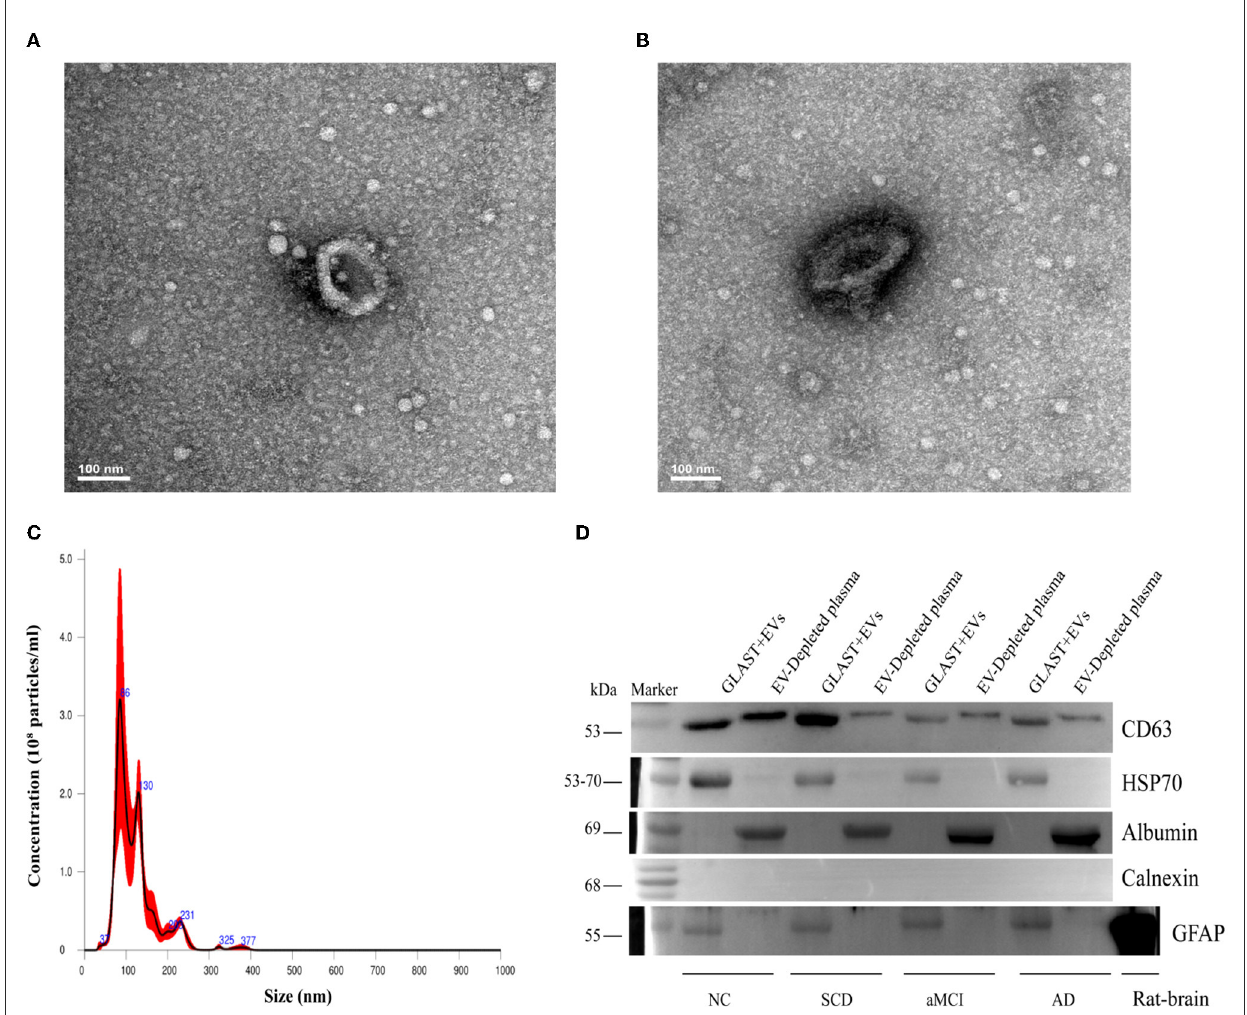
FIGURE1 Characterization of ADEs. (A, B) Typical TEM images of ADE. Characteristic image of ADE from one subject and the analysis was performed at Tsinghua University. (C) Typical NTA results. The graphs display particle concentration (particles/ml) against the size (diameter in nm) of one subject. (D) Western blot characterization of ADEs. Western blots of astrocyte-enriched (GLAST + ) plasma EVs compared to EV-depleted plasma (supernatant obtained after Exoquick ® ) from four subjects. First, compared with the supernatant, ADEs had obviously higher CD63 and HSP70 levels, demonstrating the nature of EVs. Second, compared to the supernatant, ADEs showed no albumin levels. In addition, Calnexin was not clearly observed in ADEs, suggesting purity. Third, GFAP, a classic astrocyte marker was clearly observed in ADEs, suggesting a true astrocyte origin, and rat-brain as a positive control. TEM, transmission electron microscope; ADEs, astrocyte-derived exosomes; NTA, nanoparticle tracking analysis; GLAST, glutamine aspartate transporter; NC, normal controls; SCD, subjective cognitive decline; aMCI, amnestic mild cognitive impairment; AD, Alzheimer’s